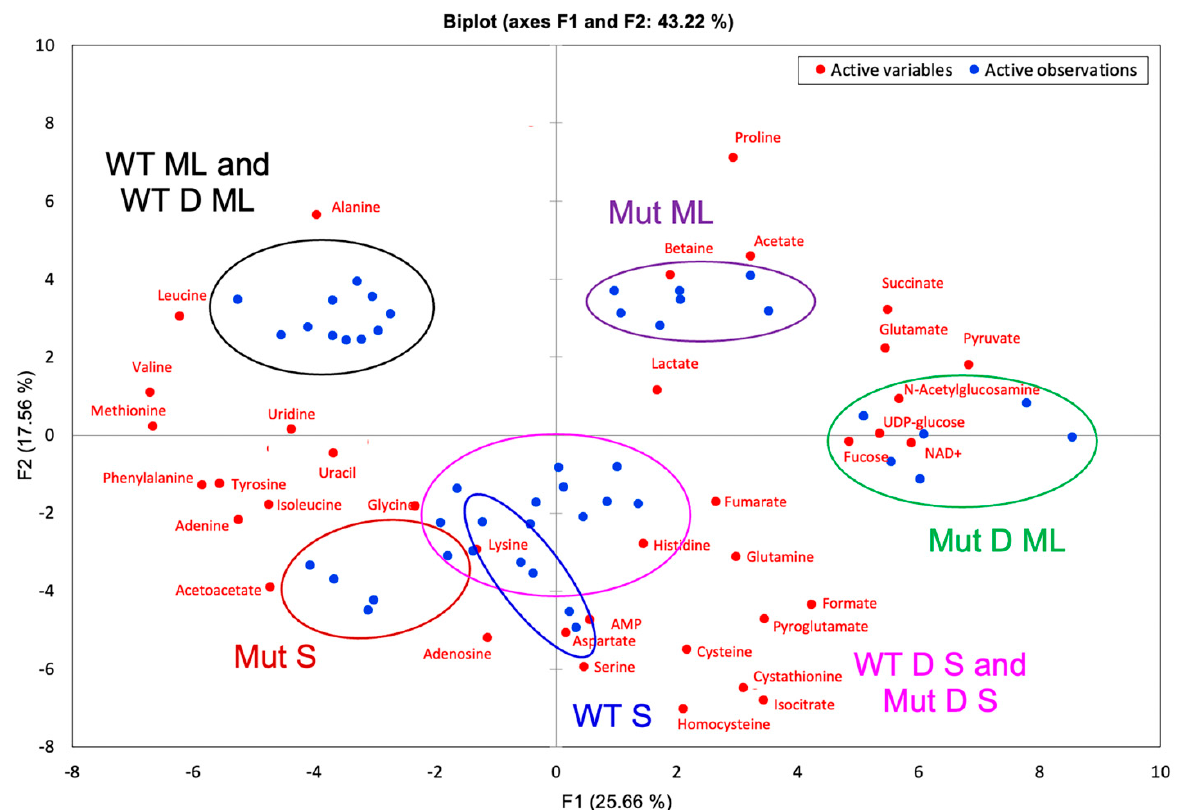
Figure 4. PCA biplot showing the distribution samples (blue dots) with color coordinated sample labels and circles and the distribution of metabolites (red dots).